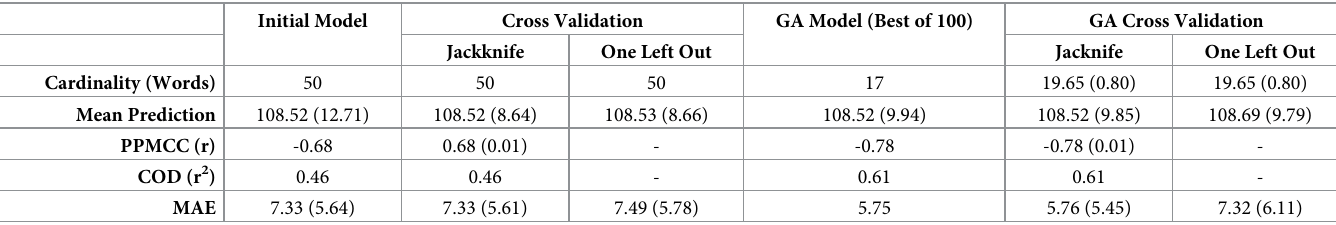
Table 1. Critical performance metrics for each models and cross validation set (standard deviation shown in parenthesis, were